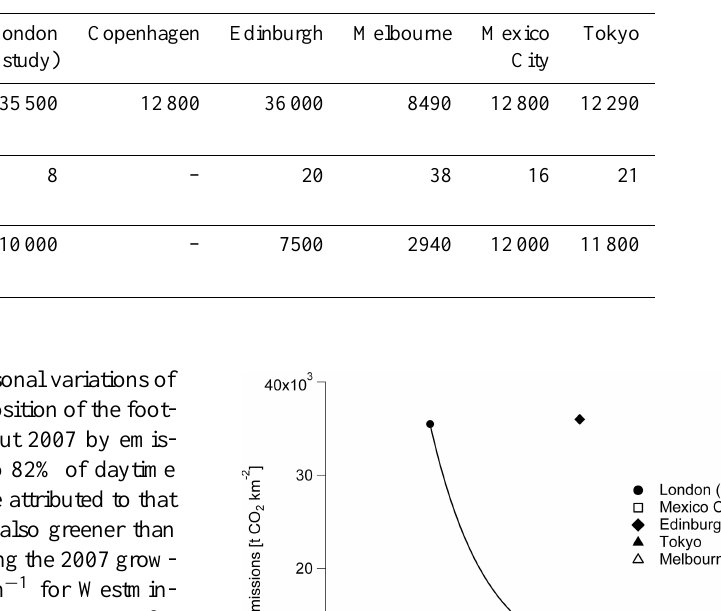
Table 6. Annual emissions estimates for six cities, plan area of vegetation and population density around the study areas (see Table 4 for references).